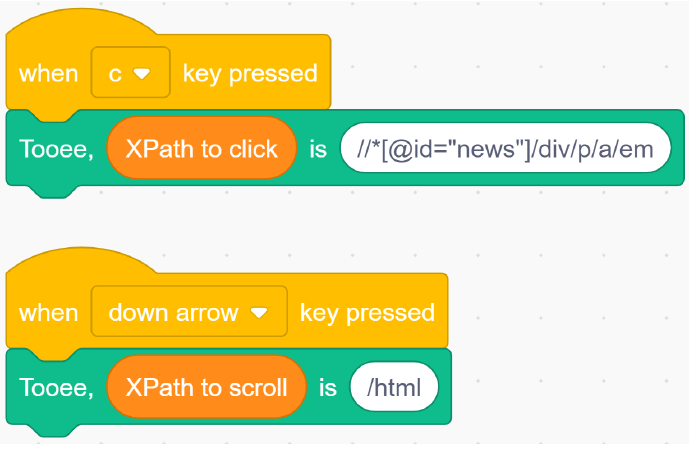
Figure 4. An example program that clicks or scrolls the specified html elements corresponding to the